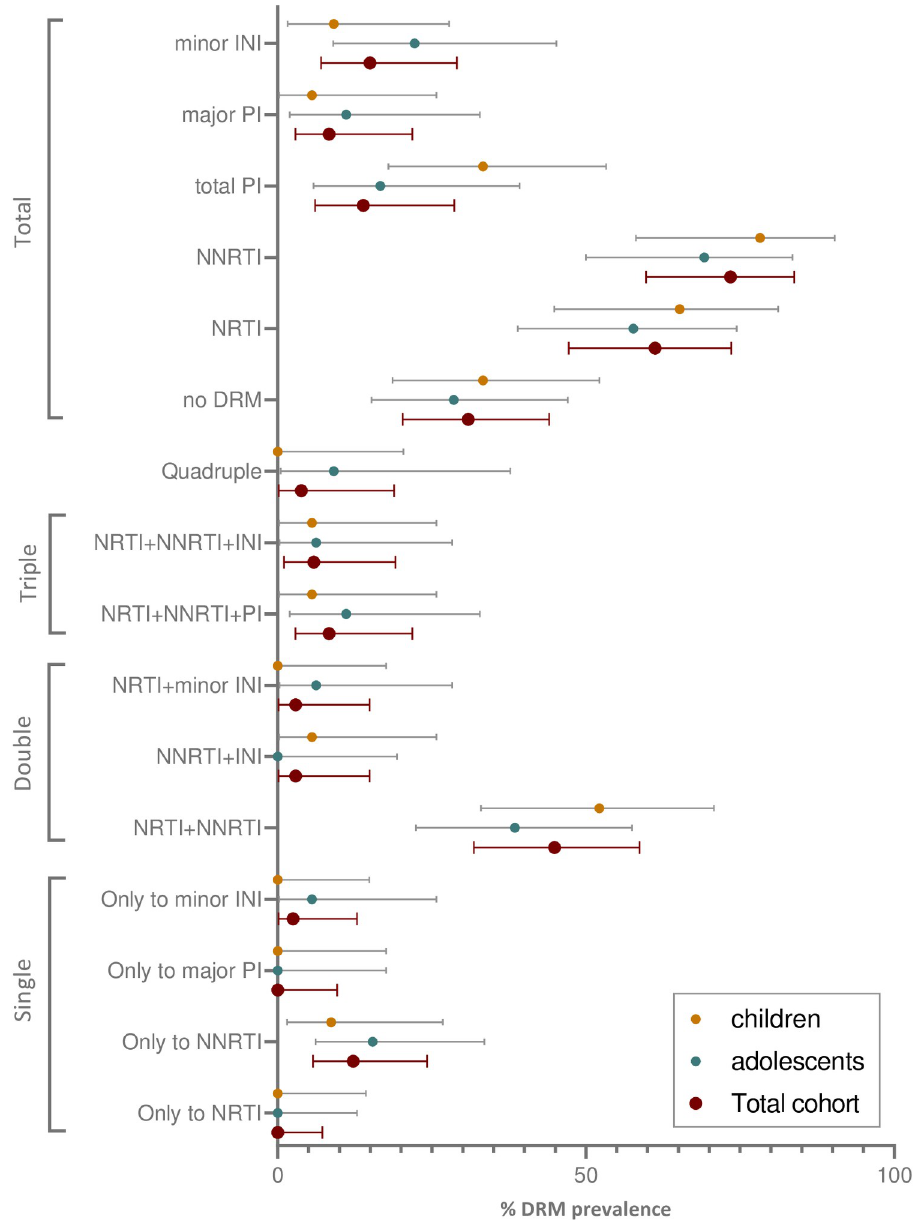
Fig 1. Rate of patients carrying DRM to the main ARV families at study population. Mean DRM prevalence (colored dots) and 95% confidence intervals on the study cohort with available sequence by age. Single resistance, to one ARV family; double, triple, or quadruple resistance and total DRM ARV families. DRM to PI are always major unless otherwise indicated. DRM to INI are always minor. ARV, antiretroviral drugs; NRTI, nucleoside transcriptase reverse inhibitor; NNRTI, non-nucleoside transcriptase reverse inhibitor; PI, Protease inhibitor; INI, integrase inhibitors. Rates calculated considering available sequences (55) reported in Table 1 . More data available in S1 Table . H/S (42.9%), Y181C/G190A (24.5% each), V108I/K101E/H (18.4% each) and H221Y/V106I (12.2% each). The three subjects with major DRM to PI carried M46I (8.3%) and two also had I54V, only one of them had previous experience to PI. Minor DRM to INI were found in 15% of subjects with available IN sequences, 9.1% children, and 22.2% adolescents. When